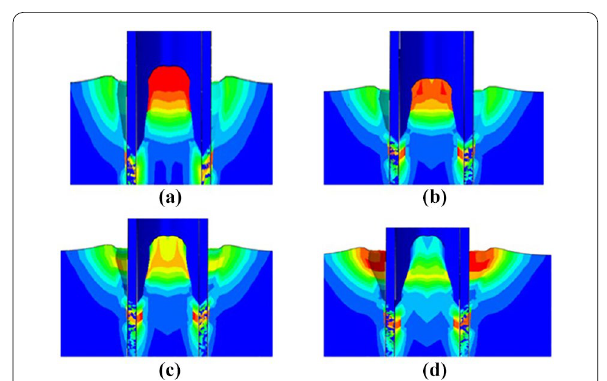
Figure 15 Simulation results of tissue deformation under different puncture speeds